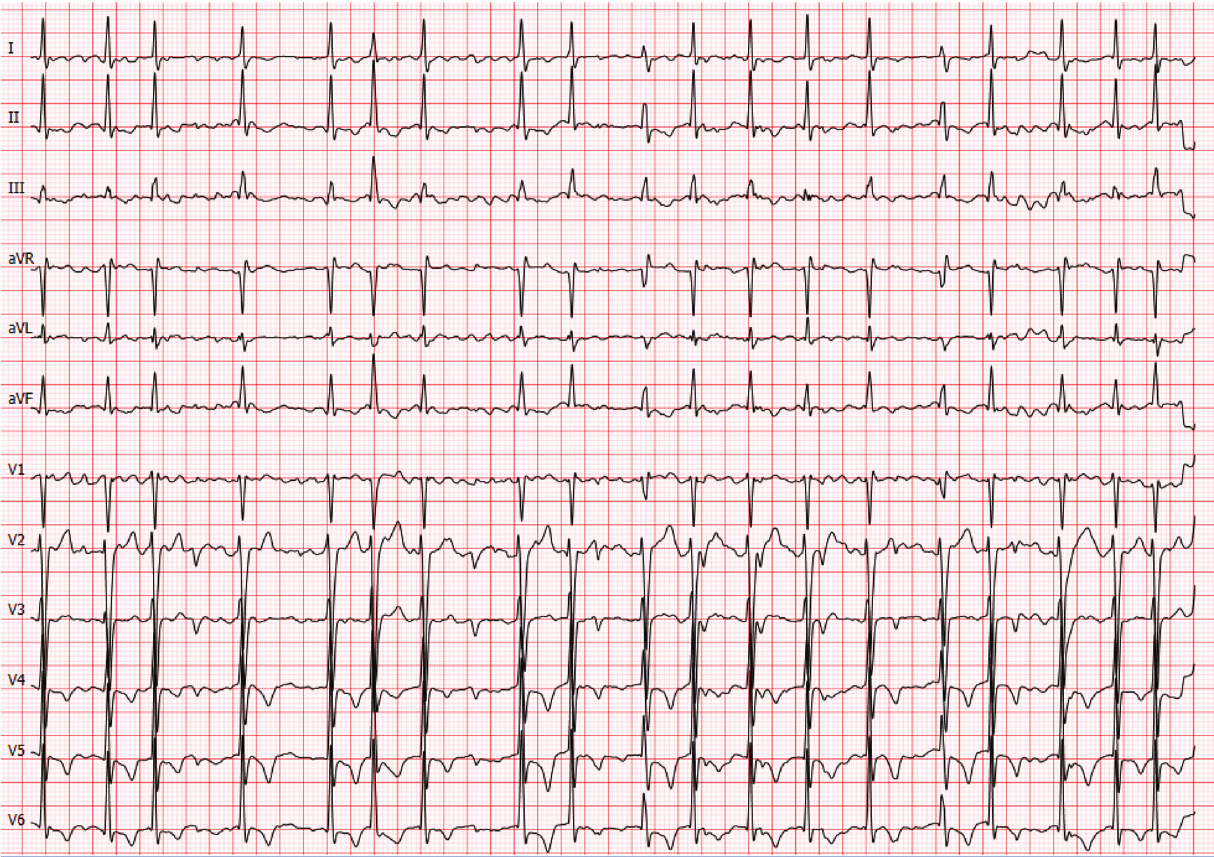
Figure 1: Resting ECG at admission. Tachycardic atrial fi brillation with irregular rhythm at a heart rate of 111 beats per minute. Repolarization showed signs of left ventricular